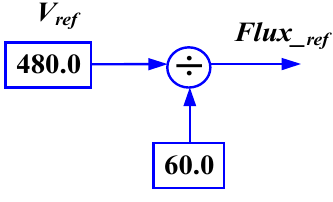
Figure 14. Reference flux estimator.